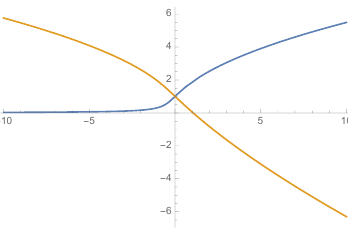
Figure 2 . The single-valued branch of the function ^ F ( x ) = F (cid:0) 2 x F 0 and F (choosing the integration constant c 1 = 0). The former is the positive de(cid:12)nite one. The latter vanishes at x (cid:25) 1 : 06 before (cid:0)p p running o(cid:11) to (cid:0)1 as 3 x log x (cf. (3.16)). We emphasize that the function ^ F and its integrated form F must be real for x (cid:21) 0, as all non-negative values of x are physically permissible. The form given above is only manifestly real for 4 x 3 (cid:20) 1. ^ F may equivalently be